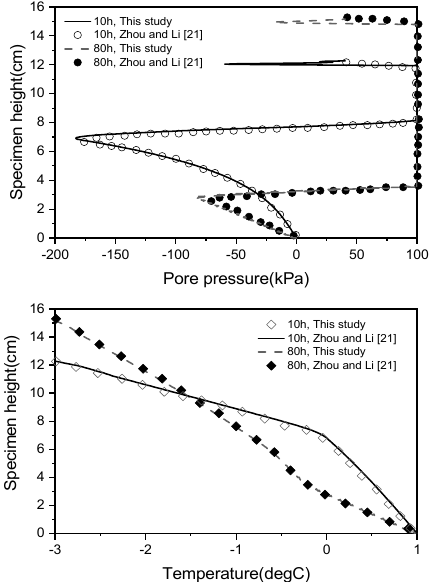
Figure 5. Comparison results with those of the previous numerical studies [21] for the 1D freezing.